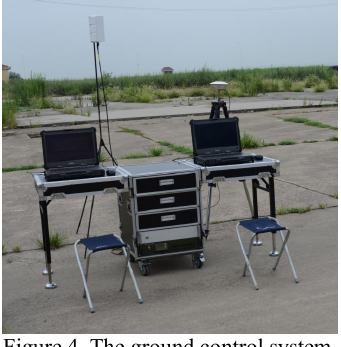
Figure 2. The antenna array of full polarimetric SAR system on the flight control computer which is mainly used for the control and monitoring of RF and digital subsystems.